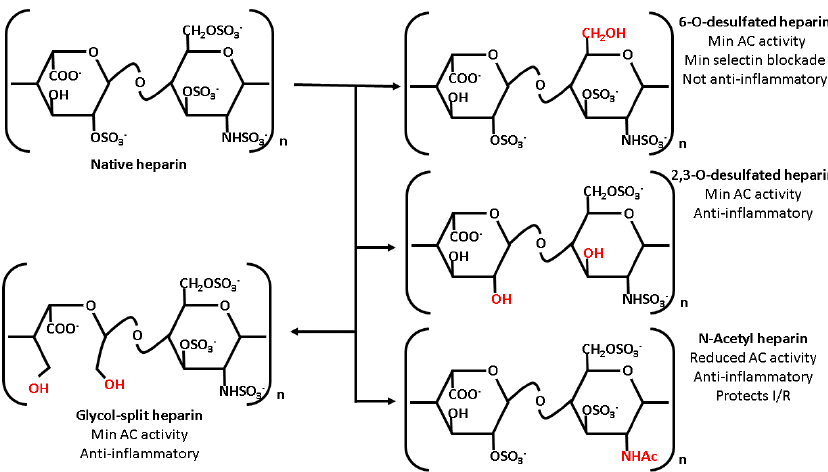
Figure 1. Summary of heparin chemical derivatives. Chemical modification of unfractionated